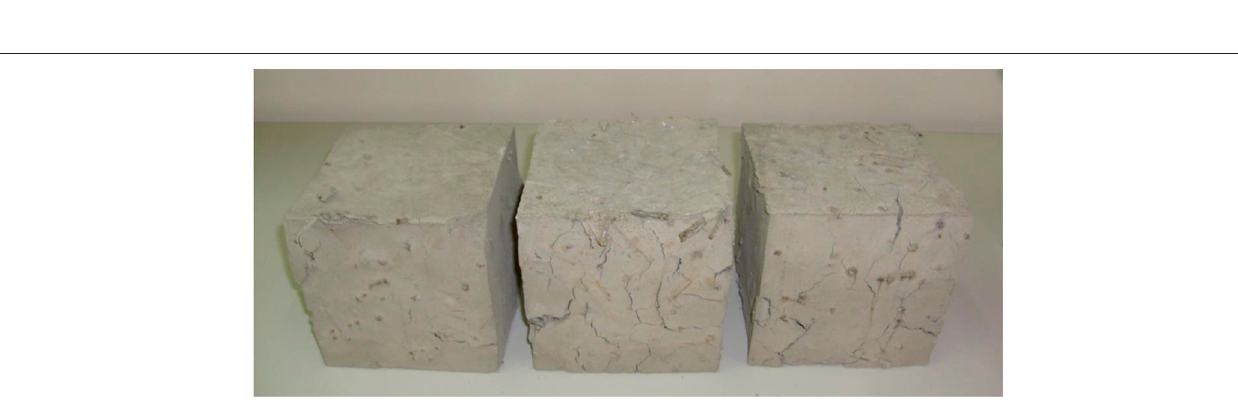
FIGURE 6 | Adobe bricks, i.e., sun-dried earth bricks, reinforced with natural fi bers.